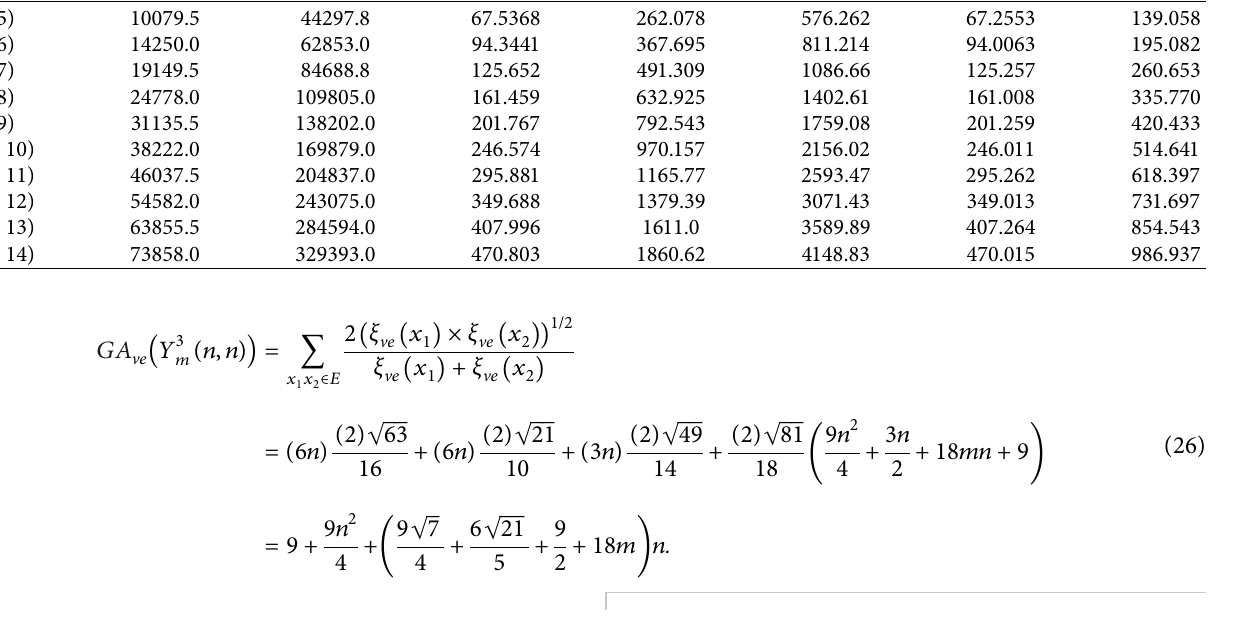
, M 2 ve , H ve , R ve , χ ve , ABC ve , GA ve for Y -junction graph Y 1 m ( n, n ) β ve